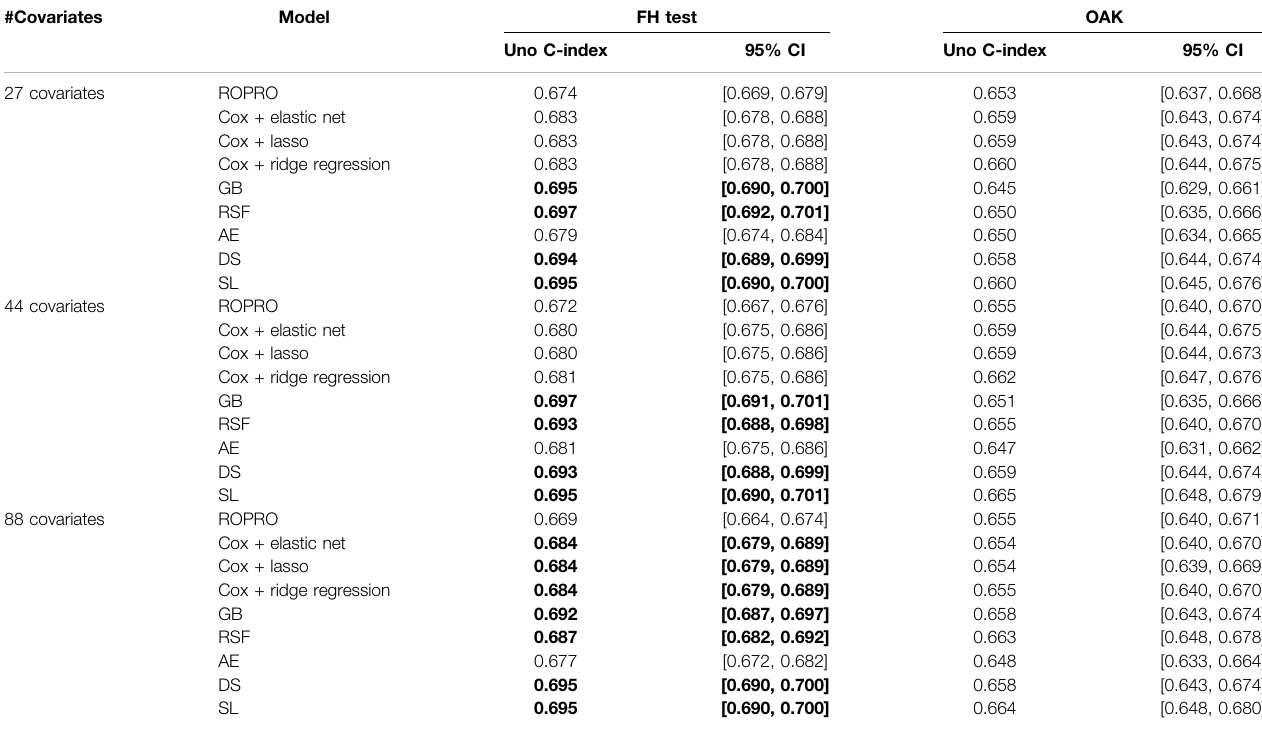
TABLE 5 | Uno C-index and corresponding 95% con fi dence intervals. Signi fi cant increases in C-index over the ROPRO model are in bold. #Covariates